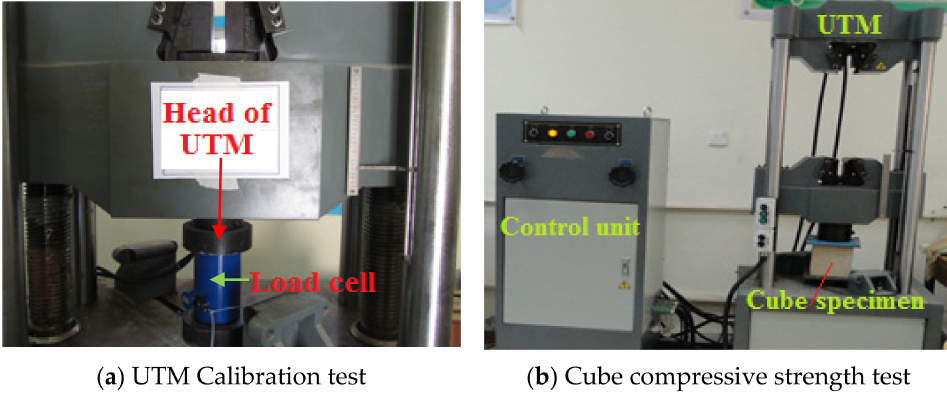
Figure 1. Concrete cubes after curing and during the test: ( a ) UTM (Universal Testing Machine) calibration test; ( b ) cube compressive strength test.